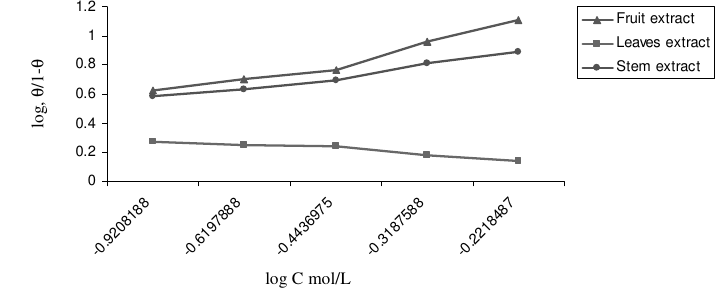
Figure 2. Longmuir adsorption isotherm for mild steel in 2.0 N (HCl+H extracts of Cordia dicotoma (24